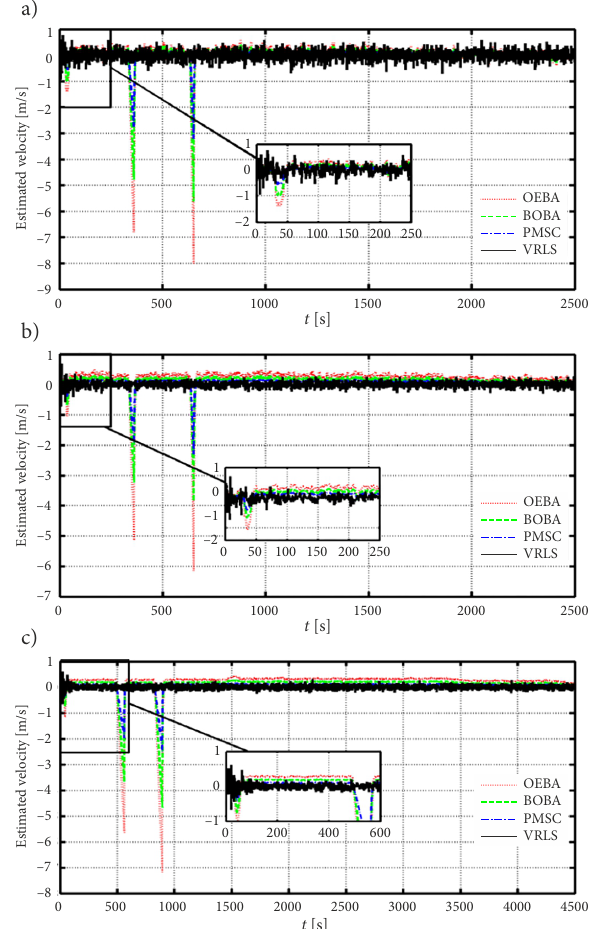
Figure 6. Estimations of velocity error for journeys with profiles: a – Journey-A with Profile-1; b – Journey-A with Profile-2; c – Journey-B with Profile-5 ing the velocity error with various accelerometer bias and